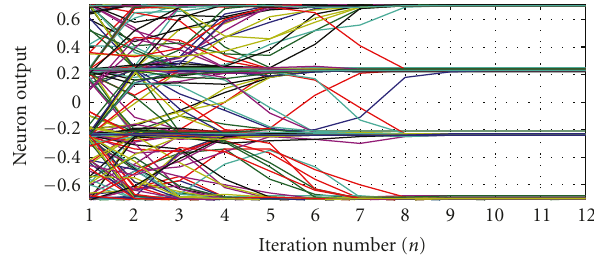
Figure 8: Convergence of the 16-QAM HNN MLSE equalizer without annealing.